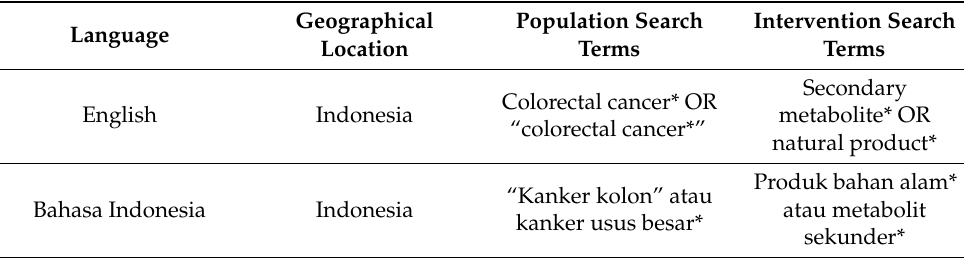
Table 1. Search string composition adopted from defined PICO with desired focus on studies from Indonesia in both English and Bahasa Indonesia.